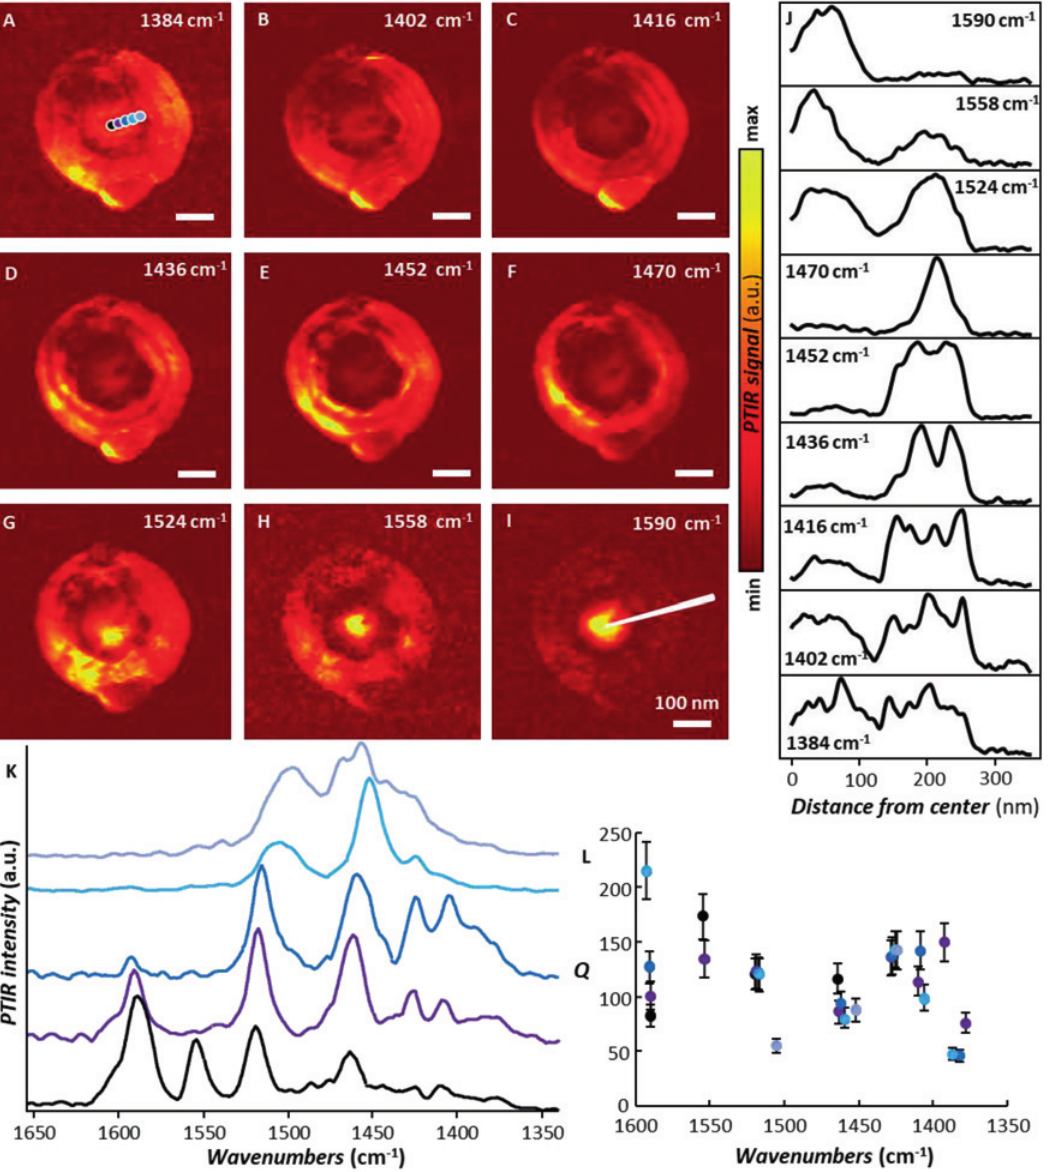
Figure 3: (A – I) Tapping-mode PTIR absorption maps for an hBN frustum of Ar = 1.16 ± 0.03. All images (3 and 7.5 nm pixel resolution in the horizontal and vertical directions respectively) were obtained with a scan rate of 0.6 Hz using probe-B. Scale bars are 100 nm. (J) Line cuts of the PTIR images along the direction indicated by the white line in panel-I. (K) Tapping-mode PTIR spectra obtained at the color-coded position in panel-A. The spectra are displayed in full scale with an offset for clarity. (L) Q-factors of the polariton resonances obtained from the color- coded spectra in panel-K. The error bars represent a single standard deviation in the determination of Q and mainly determined by the uncertainty of determining the peaks FWHM via the least square fi tting the resonances with Lorentzian peak